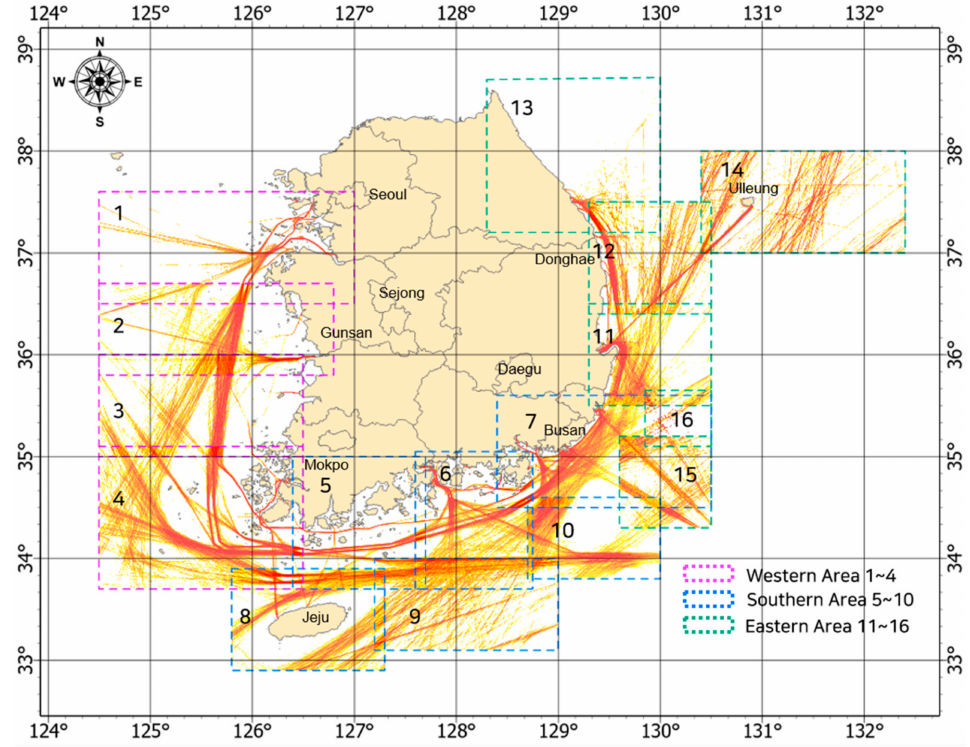
Figure 5. Final result of the Korean main maritime traffic